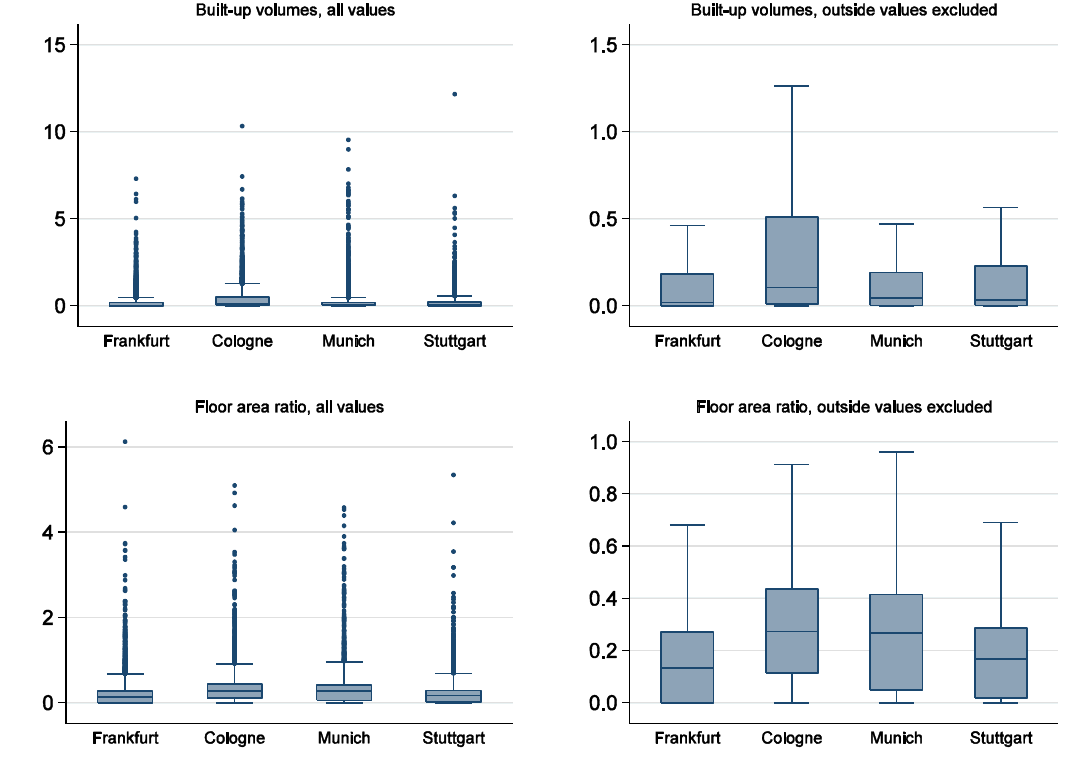
Figure 6. Box plots of built-up volumes (million m 3 ) and floor area ratios.